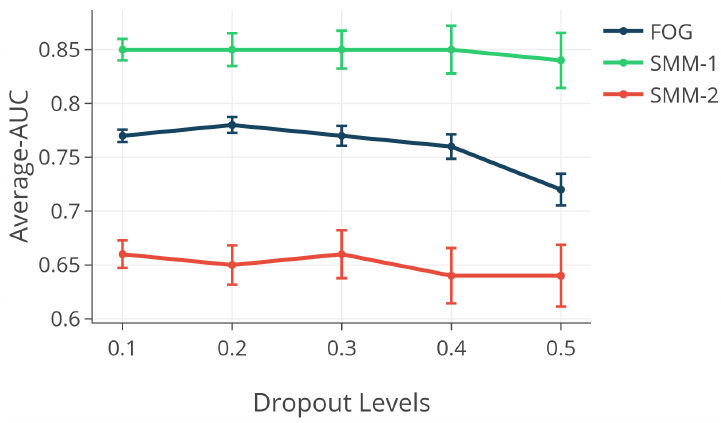
Figure 4. The effect of different dropout probabilities on the performance of the normative modeling